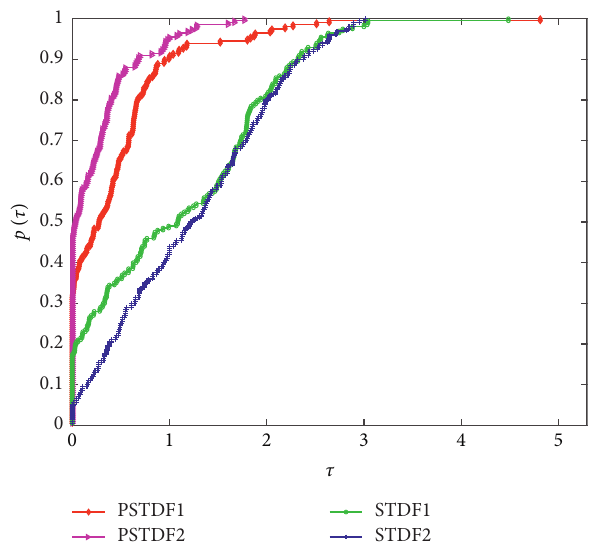
Figure 3: Performance profiles for the CPU time (in